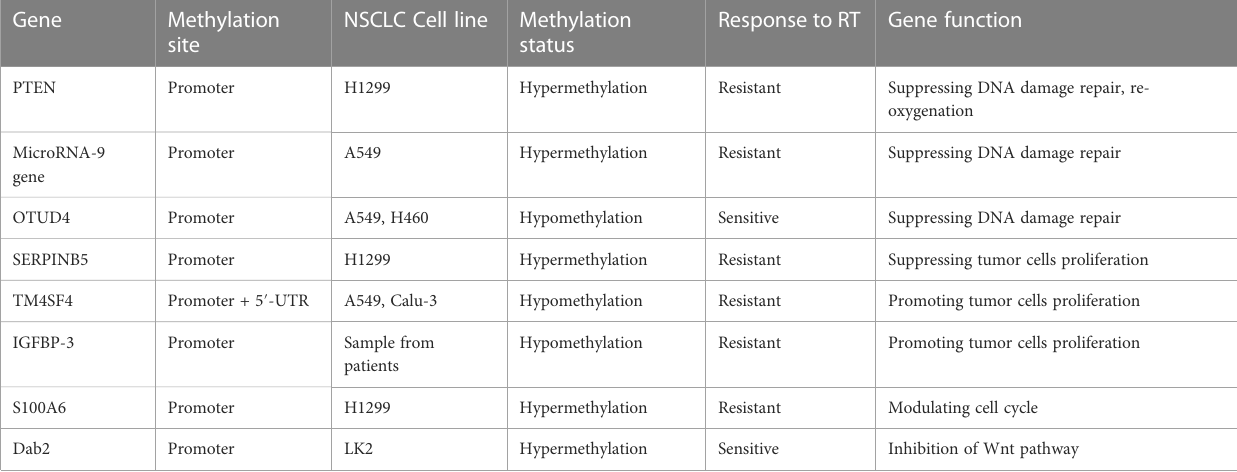
TABLE 5 Radiosensitivity related genes regulated by DNA methylation in